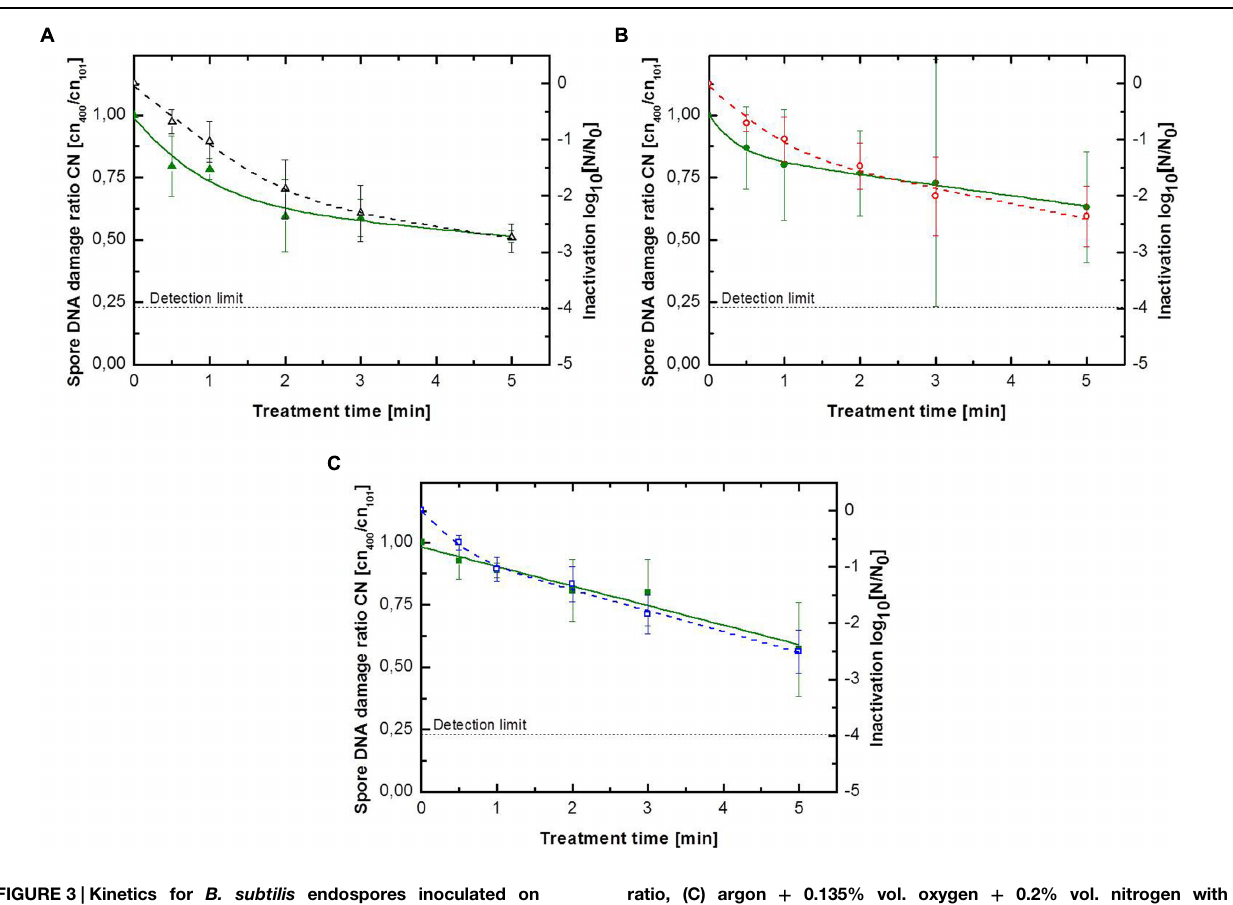
FIGURE 3 | Kinetics for B. subtilis endospores inoculated on glass petri-dishes for (A) pure argon with ( (cid:3) ) inactivation and ( (cid:3) )endospore DNA damage ratio, (B) argon + 0.135% vol. oxygen with ( (cid:4) ) inactivation and ( • )endospore DNA damage